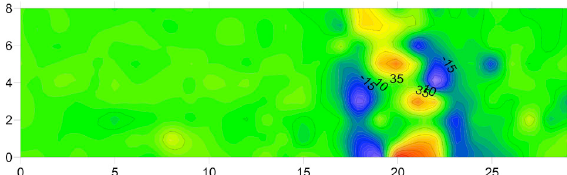
Figure 5. Confirming the kiln site after magnetic prospection